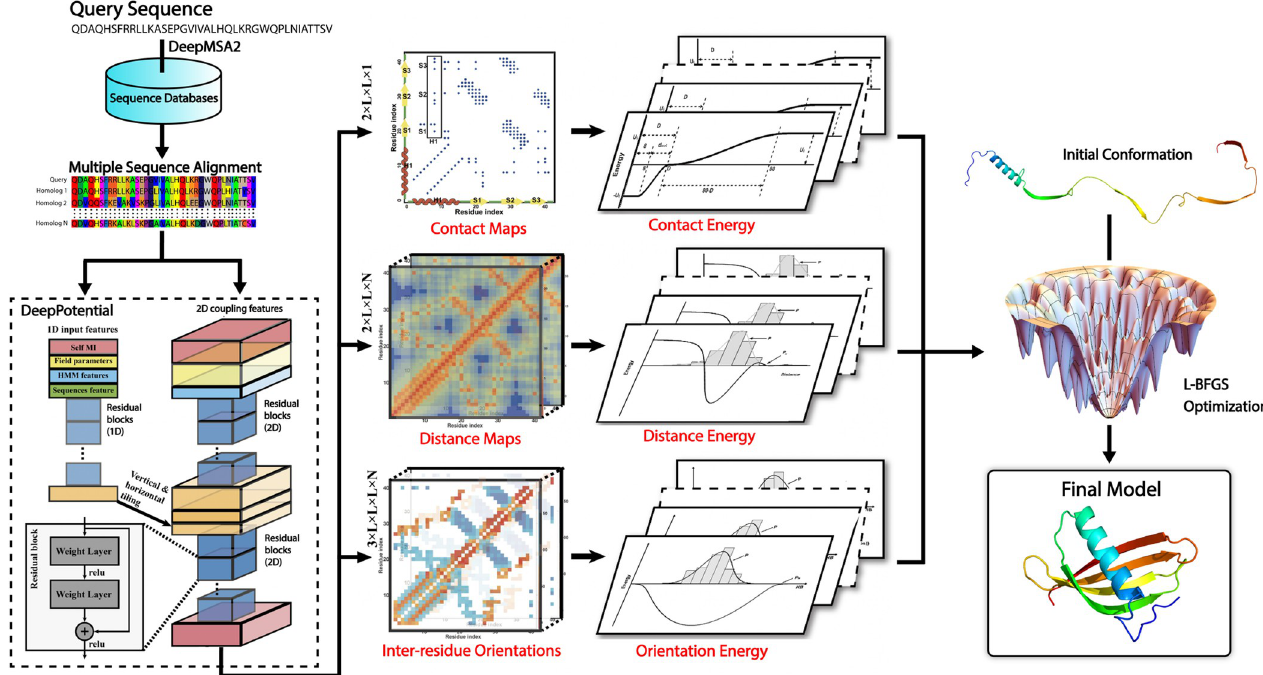
Fig 1. Overview of the DeepFold pipeline. Starting from a query amino acid sequence, DeepMSA2 is used to search the query against multiple whole-genome and metagenome sequence databases to create a multiple sequence alignment (MSA). The MSA is then used by DeepPotential to derive input features based on co-evolutionary analyses for the deep ResNet training. DeepPotential outputs the probability distribution of the C β -C β /C α -C α contact and distance maps as well as the inter-residue orientations. These restraint potentials along with the inherent statistical energy function are used to guide the L-BFGS folding simulations for final full-length structure model